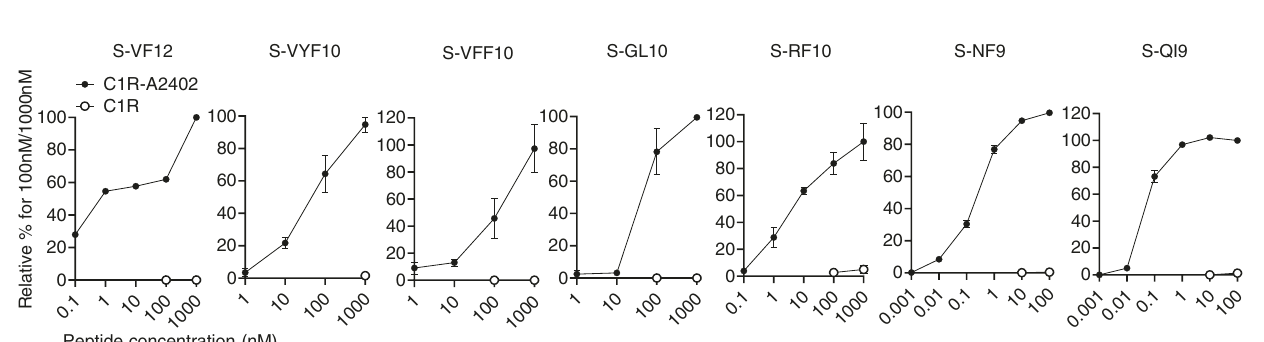
Fig.3|AbilityofHLA-A*24:02-restrictedCD8 + Tcellsspeci fi cforspikeepitopes to recognize epitope peptides. Recognition of 7 HLA-A*24:02-restricted spike epitope peptides by SARS-CoV-2-speci fi c CD8 + T cells from HLA-A*24:02 + , vacci- nated individuals. T cellresponsesof bulk cultured T cells wereanalyzed using ICS assays after exposure to C1R-A*2402 or C1R cells pre-pulsed with various